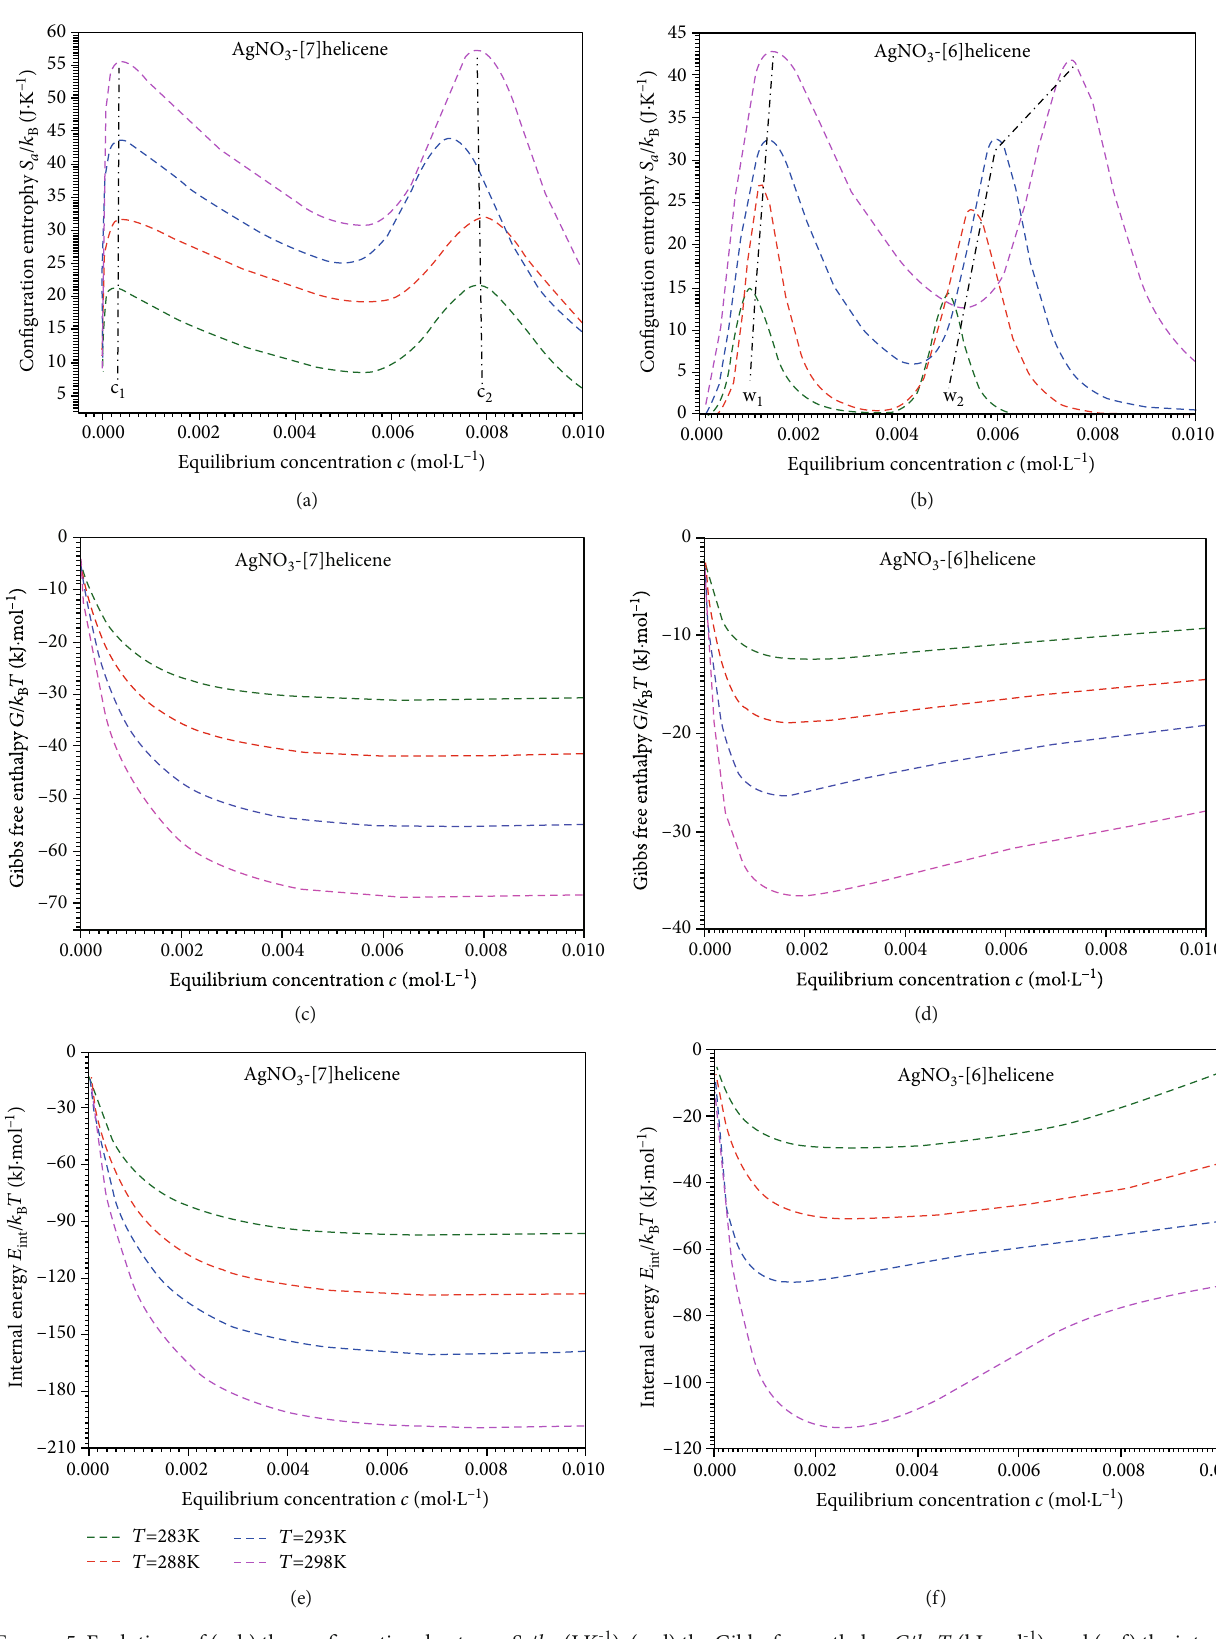
T (kJ · mol -1 ), and (e, f) the internal B